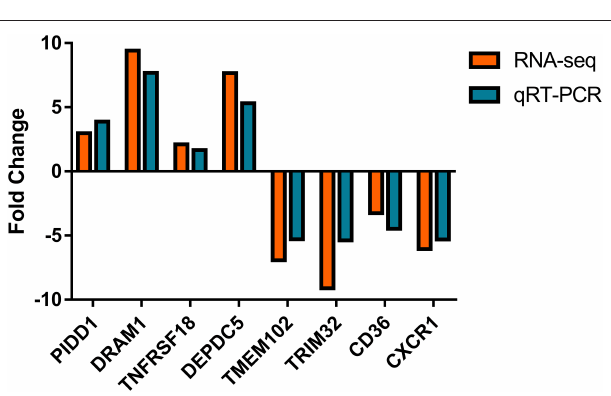
FIGURE 10 | Expression levels of selected DEGs quantified by quantitative reverse transcription-PCR (qRT-PCR). GAPDH, ACTB, and PPIA were used as an internal control, and data are presented as fold change ( N = 3 per